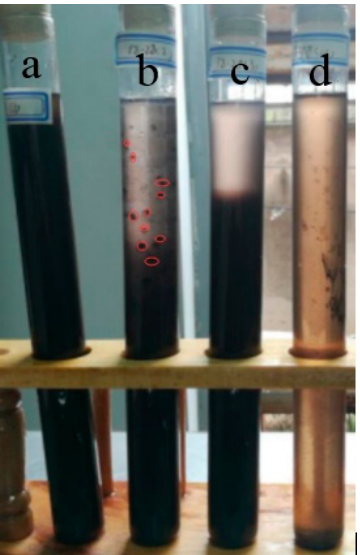
Figure 7. Photo of nanofluids with different dispersants after 30 days of settling time: ( a ) oleic acid; ( b ) glyceryl monostearate; ( c ) Span 80; ( d ) Tween 40.